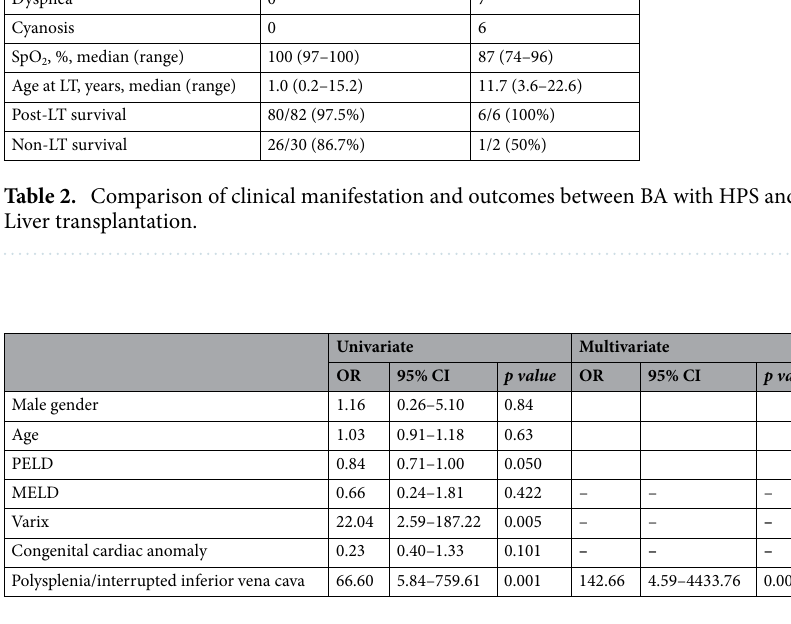
Table 3. Univariate and multivariate analysis of risk factors for hepatopulmonary syndrome in children with BA. MELD Model for end-stage liver disease, OR odds ratio, PELD pediatric end-stage liver